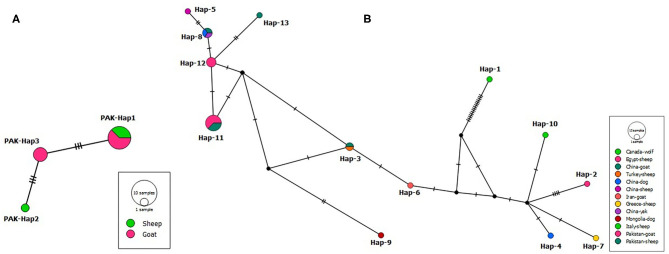
(A) Median-joining network of Coenurus cerebralis isolates from Pakistani sheep and goats based on cox1 gene (639 bp) sequences. Circle sizes are proportional to the haplotype frequencies. Hatch marks represent the number of mutations. Small black spheres are median vectors i.e., unsampled or hypothetical haplotypes. (B) Median-joining network of Taenia multiceps isolates from different hosts and geographical locations based on the mitochondrial cox1 gene (339 bp) sequences. Circle sizes are proportional to the haplotype frequencies. Hatch marks represent the number of mutations. Small black circles are median vectors (i.e., hypothetical haplotypes).